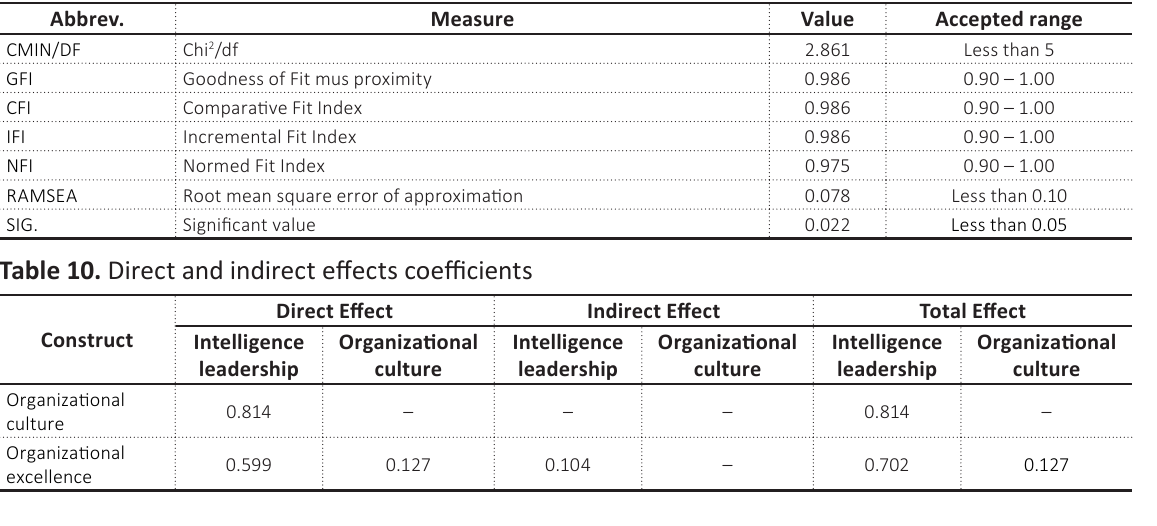
Table 9. Model fit measures